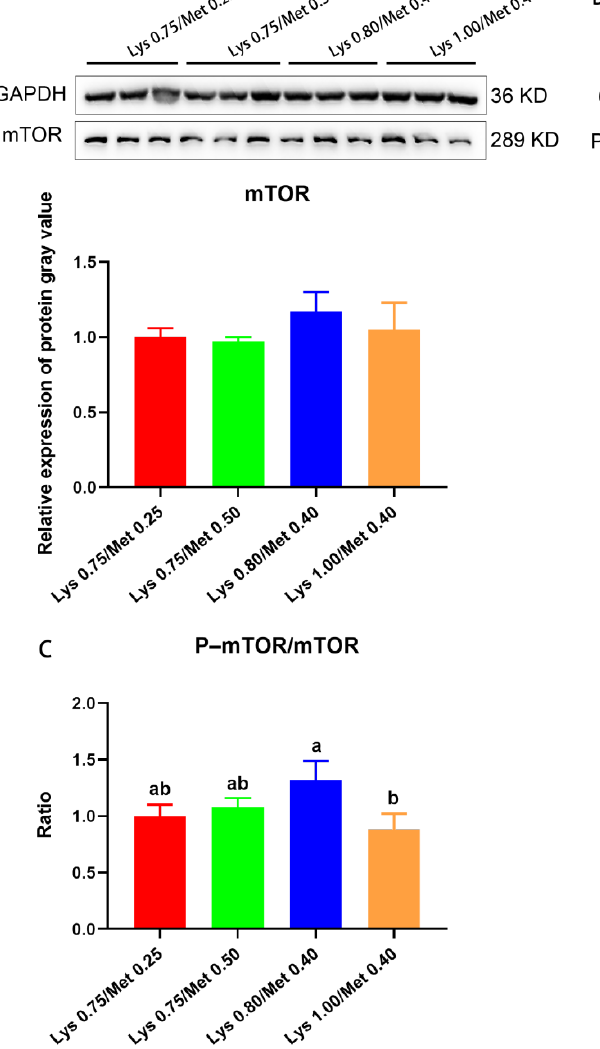
Figure 3. Effects of lysine and methionine composition in the diet on the mTOR signaling pathway in rabbit muscle. ( A – C ) Detection of the mTOR signaling pathway in rabbit muscle. Relative mTOR protein expression in muscle ( A ), relative levels of phosphorylated mTOR protein (P – mTOR) in muscle ( B ), and the P – mTOR/mTOR ratio ( C ). Data are expressed as means ± SEM (n = 3). Comparisons between groups that contain only different lowercase letters indicate significant differences ( p < 0.05). Western blots for each set of reference protein and target protein were from one blot, and the black line was the cropped edge of the blot.